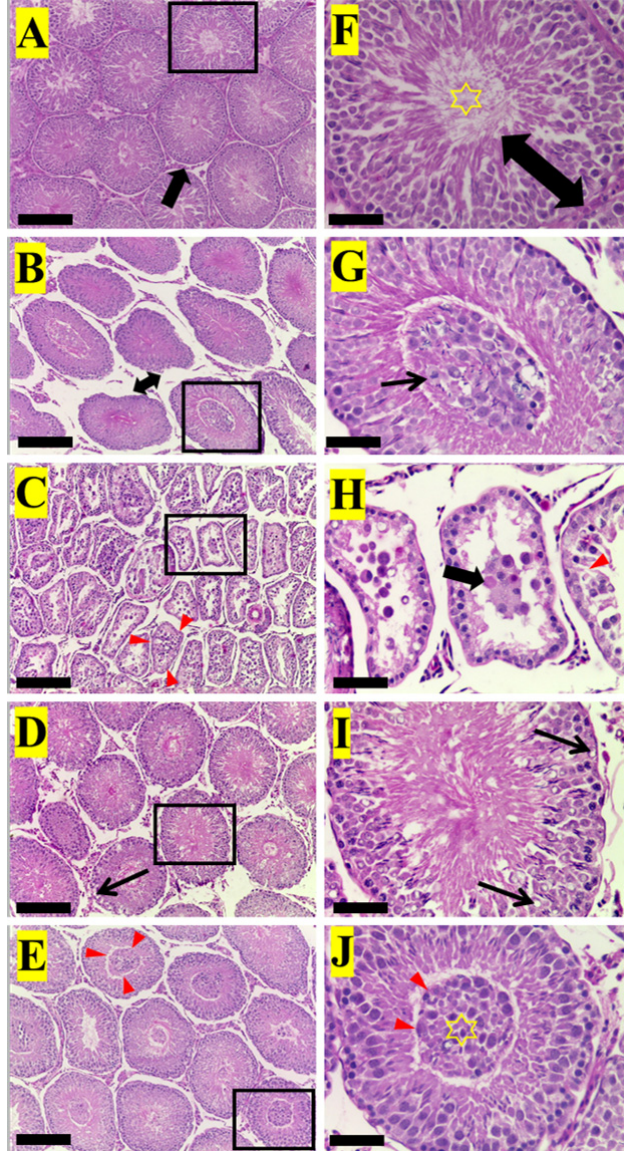
Figure 2. Representative photomicrographs of an H&E-stained testicular section. Testis of the control group (image ( A )) showed a normal oval-shaped seminiferous tubule (ST) separated by a layer of interstitial connective tissue (thick arrow). Changes in the normal testicular morphology were observed in animals from the treated groups. Image ( B ) (DM group) shows an increased interstitial space (double arrow), image ( C ) (DM+A group) shows extensive tubular atrophy and germinal epithelium derangement (arrowheads), image ( D ) (DM+cART group) shows lifting of the epithelium (thin arrow), and image ( E ) (DM+A+cART group) shows epithelial sloughing (arrowheads). Images ( F – J ) are magnified views of the square area indicated in images ( A – E ). As demonstrated in the image, ( F ) is the germinal epithelium (double arrow) consisting of a discretely arranged series of spermato- genic cells and a lumen (asterisk), ( G ) shows germ cell pyknosis (thin arrow), H shows a ghost cell (thick arrow) and widened intercellular space (arrowhead), ( I ) shows karyolysis (thin arrow), and ( J ) shows sloughed germ cells in the lumen (asterisk) and germ cells of increased size (arrowheads). DM, diabetes; DM+A, diabetes and alcohol; DM+cART, diabetes and combination antiretroviral therapy; DM+A+cART, diabetes and alcohol and combination antiretroviral therapy. The left and right panels are × 100 and × 400 magnifications with scale bars of 200 µ m and 50 µ m